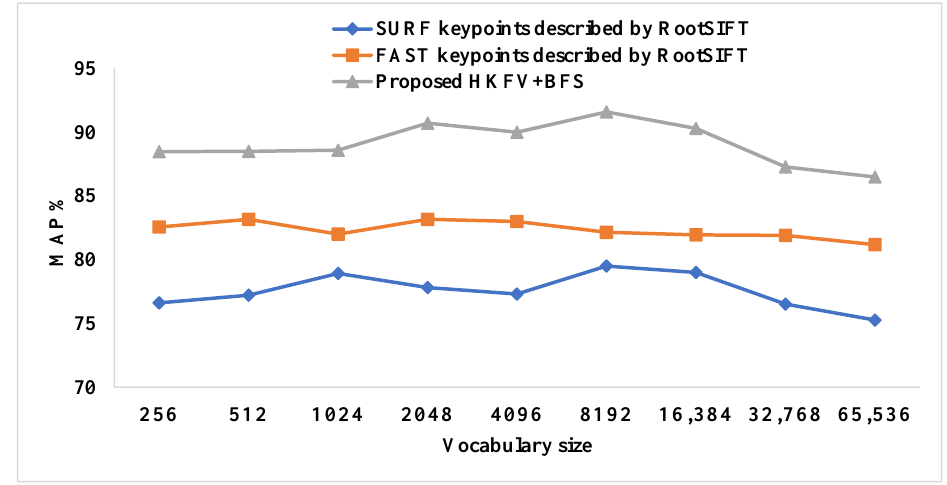
Figure 11. HKFV using 50% BFS vs. standalone FAST and SURF on the Corel-1000 dataset.